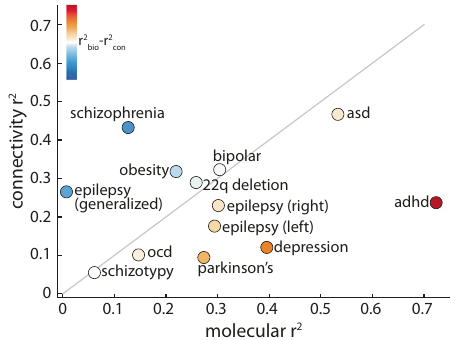
Fig. 3 | Comparing molecular and connectomic contributions to disorder- speci fi c cortical differences. The local molecular R 2 adj of each disorder is plotted against the global connectivity R 2 adj . The grey line indicates the identity line and circle colour represents the difference between molecular and connectomic R 2 adj , suchthat warm coloursrepresentdisordersthat are better predicted bymolecular predictors, and cool colours represent disorders that are better predicted by connectomic